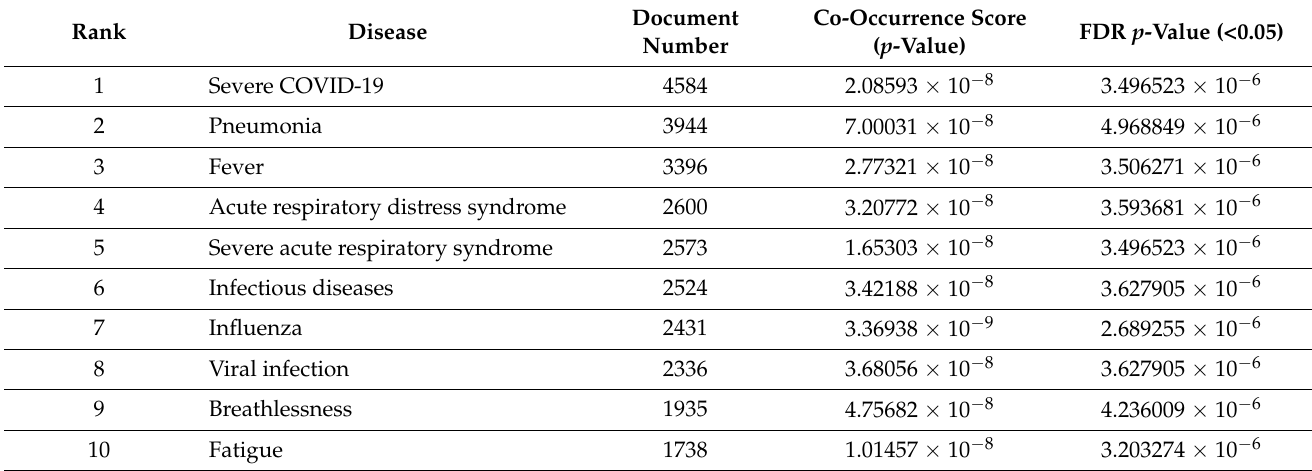
Table 3. The top 10 diseases that significantly co-occurred with COVID-19 in the query